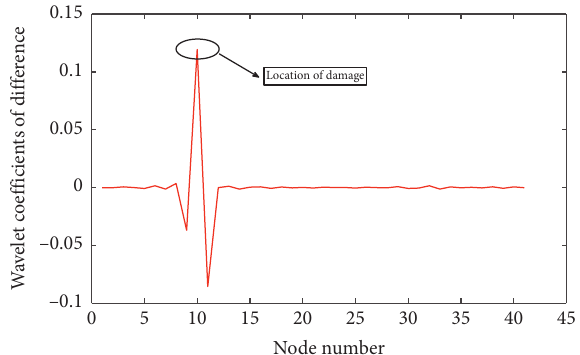
Location of damage